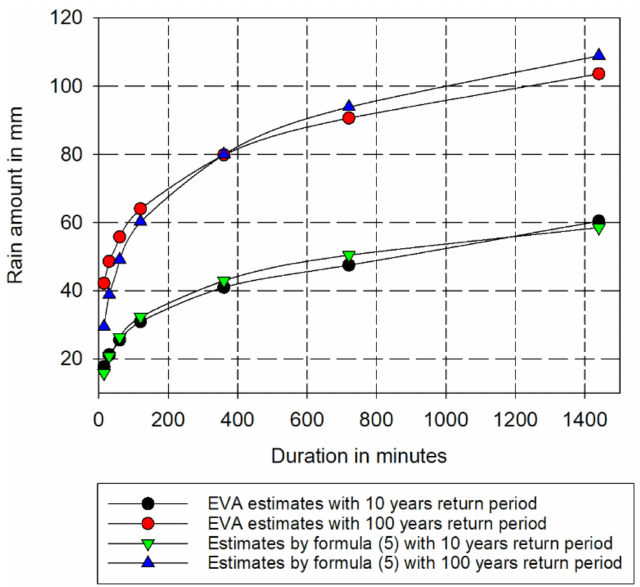
Figure 2. Illustration of the primitive relationship (5) with IDF data from London. The upper curves represent rainfall with a return period of 100 years and the lower curves represent 10 years of recurrence. Duration spans from 5 min to 24